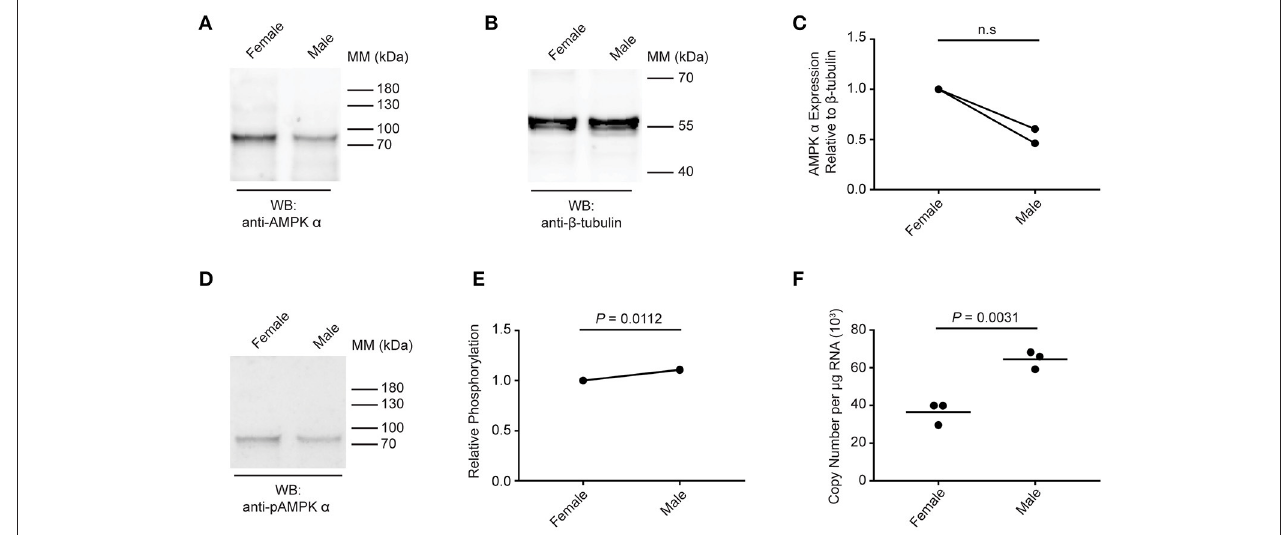
FIGURE 4 | Expression and phosphorylation of AMPK α in female and male schistosomes. (A) Lysates of adult female and male schistosomes were probed by Western blot with anti-AMPK α antibodies. (B) Lysates of adult female and male schistosomes were probed by Western blot with anti- β -tubulin antibodies. (C) The intensity of the anti-AMPK α signal relative the anti- β -tubulin signal for each sample was determined, and the signals normalized to that obtained with female worms (results from two independent biological replicates are shown). (D) Lysates of adult female and male schistosomes were probed by Western blot with anti-pAMPK α antibody. (E) The intensity of the anti-pAMPK α signal relative the anti-AMPK α signal [from (A) ] for each sample was determined, and the signals normalized to that obtained with female worms (results for two independent biological replicates are shown). (F) AMPK α transcripts in adult female and male S. mansoni were quantified using quantitative real-time RT-PCR. WB, indicates the antibody used for Western blotting; Positions of molecular mass (MM) markers, in kilodaltons (kDa), are indicated to the right of each blot.